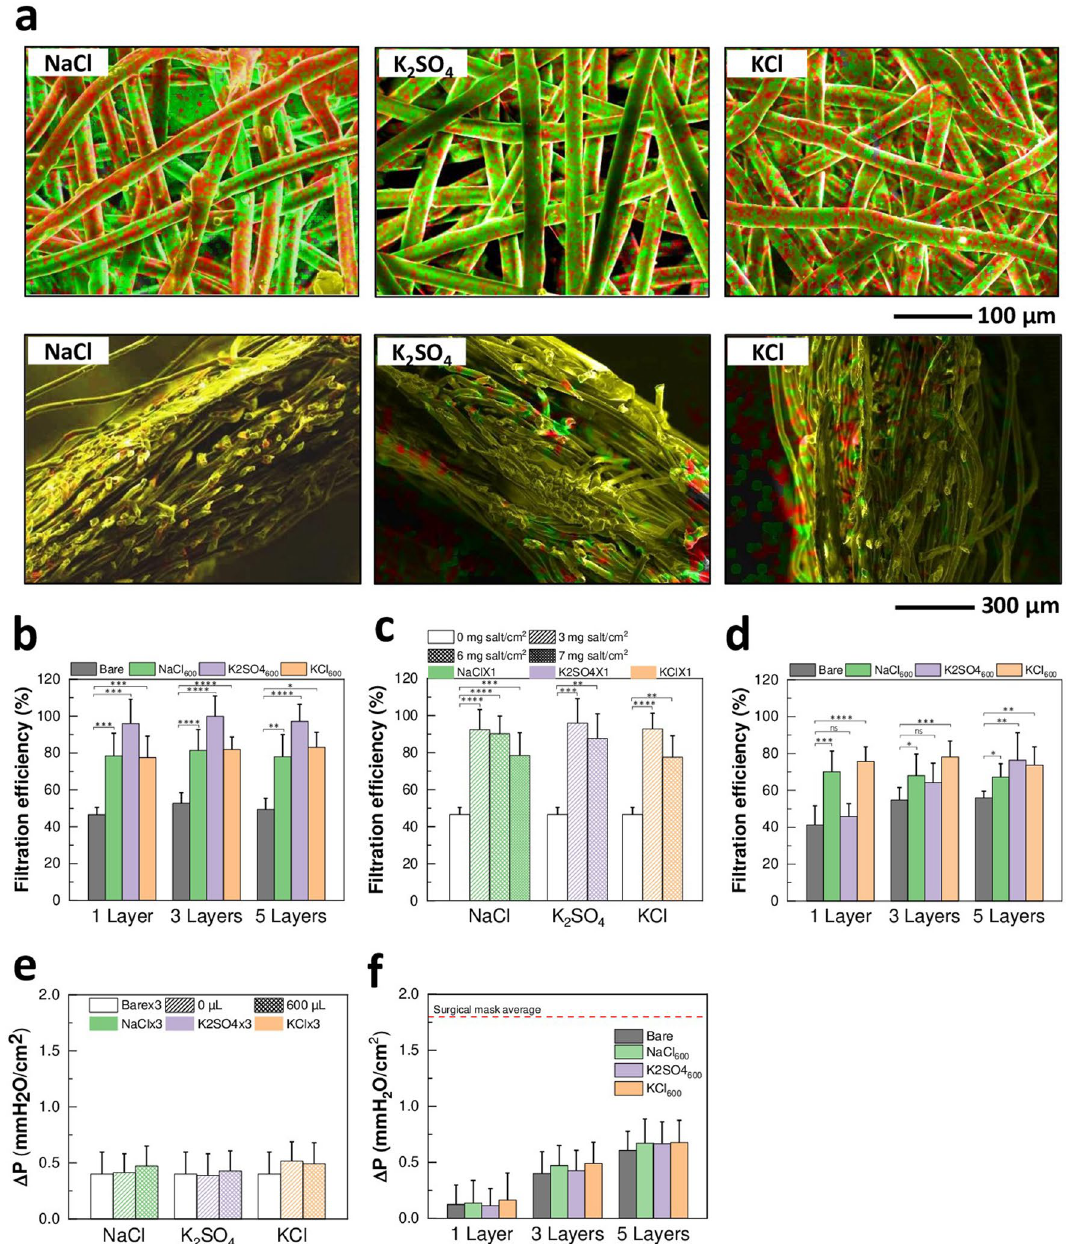
Figure 1. Characterization and performance of salt-coated filters. ( a ) EDX mapping images of NaCl (left— combination of Na (red) and Cl (green) mapping images), K 2 SO 4 [center—combination of K (red) and S (green)], and KCl [right—combination of K (red) and Cl (green)] filters, showing formation of NaCl, K 2 SO 4 , and KCl coatings, respectively. Top: plain view, bottom: cross-sectional view. ( b ) Filtration efficiency of Bare, NaCl 600 , K 2 SO 4 600 , and KCl 600 with 1, 3 and 5 stacked layers with no air flow [ n = 7–20, mean ± standard deviation (SD)]. ( c ) Filtration efficiency of Bare × 1, and NaCl × 1, K 2 SO 4 × 1, and KCl × 1 coated with 3, 6 and 7 mg salt/cm 2 with no air flow ( n = 7–15, mean ± SD). ( d ) Filtration efficiency of Bare, NaCl 600 , K 2 SO 4 600 , and KCl 600 with 1, 3 and 5 stacked layers at an air flow rate of 15 Lpm ( n = 10, mean ± SD). ( e ) Pressure drop of Bare × 3, and NaCl × 3, K 2 SO 4 × 3, and KCl × 3 coated with different amount of salt ( n = 26–45, mean ± SD). No star: ns. ( f ) Pressure drop of Bare, NaCl 600 , K 2 SO 4 600 , and KCl 600 with 1, 3 and 5 stacked layers ( n = 27–65, mean ± SD). No star: ns. Dotted line: average pressure drop of commercial surgical mask. For all panels: ns: P > 0.05; * P < 0.05; ** P < 0.01; *** P < 0.001; **** P < 0.0001, by